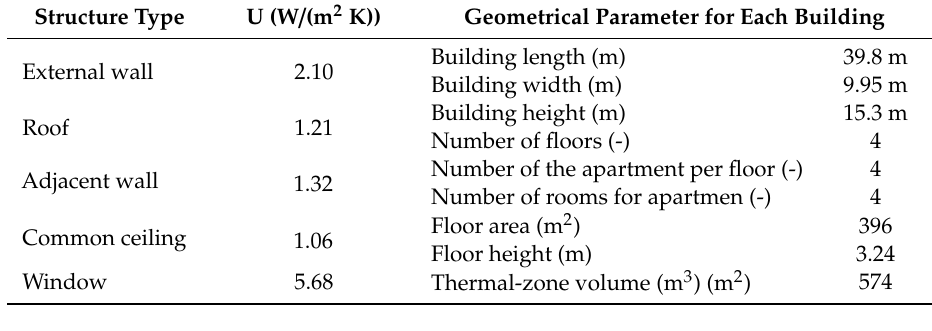
Figure 2. Schedule occupation.